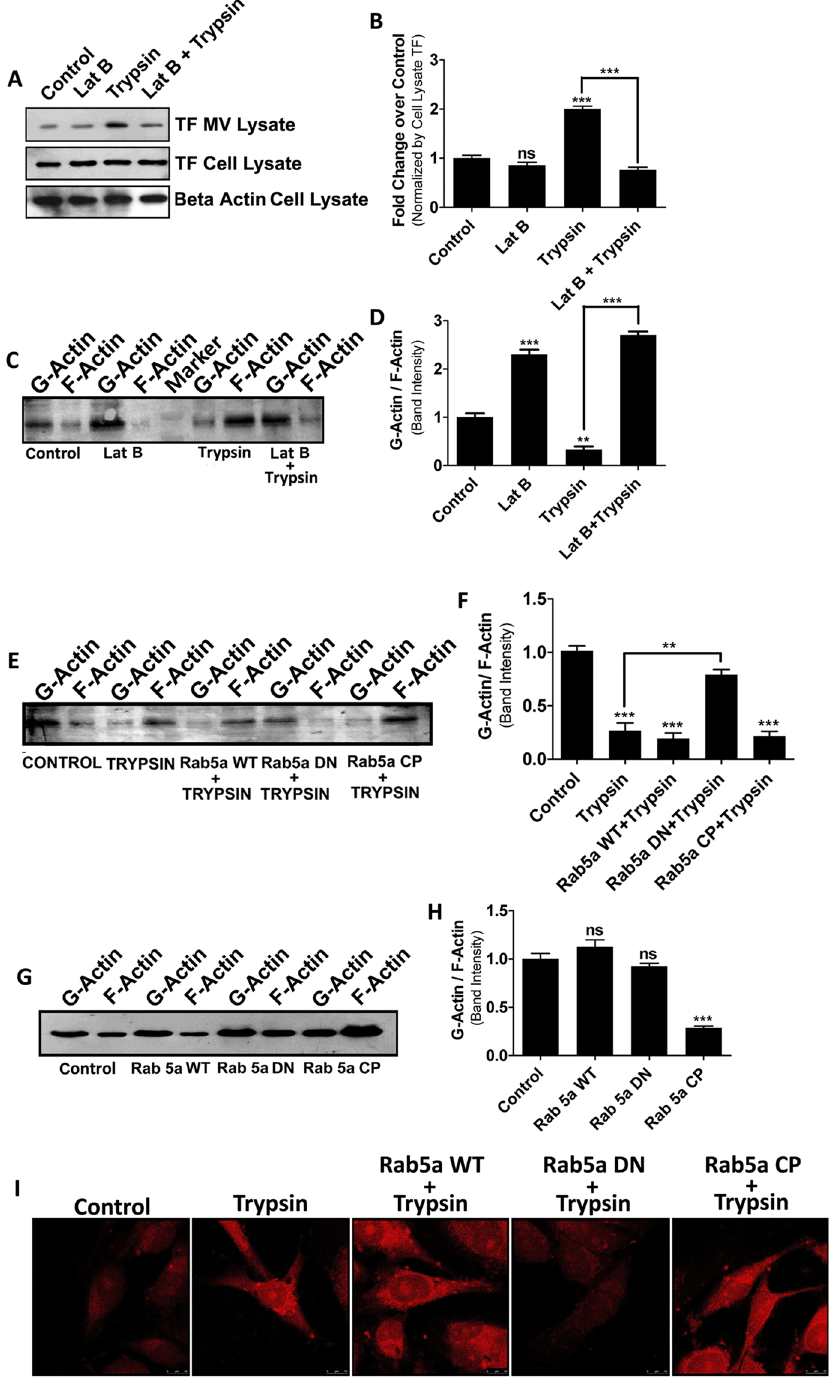
Figure 3. Trypsin Induced Rab5a Activation Promotes MVs Generation via Polymerization of Actin. MDA-MB-231 cells were challenged with Latrunculin B (200 µ M) for an hour followed by treatment with trypsin and MVs generation was analyzed by western blotting with TF antibody and graph was prepared by GraphPad Prism5 ( A ) and ( B ). G-/F-actin quantification was also performed of these cells to determine the extent of actin polymerization ( C ) and ( D ). Cells were transfected with plasmid constructs of Rab5a, followed by trypsin treatment and G-/F-actin quantification was analyzed ( E ) and ( F ). Cells were transfected with various Rab5a constructs and G-/F-actin ratio was measured accordingly ( G ) and ( H ). MDA-MB-231 cells were challenged with Rab5a plasmids followed by trypsin addition. 5 hours later, cells were fixed with 4% para- Formaldehyde, permeabilized with 0.1% Triton-X-100 and stained with phalloidin red. Images were taken by a confocal microscope and the extent of actin polymerization was monitored. Data presented over here are as Mean + / − S.E. of the Mean and differences are statistically significant at p < 0.05 using student’s t-test. The experiments were performed for at least three